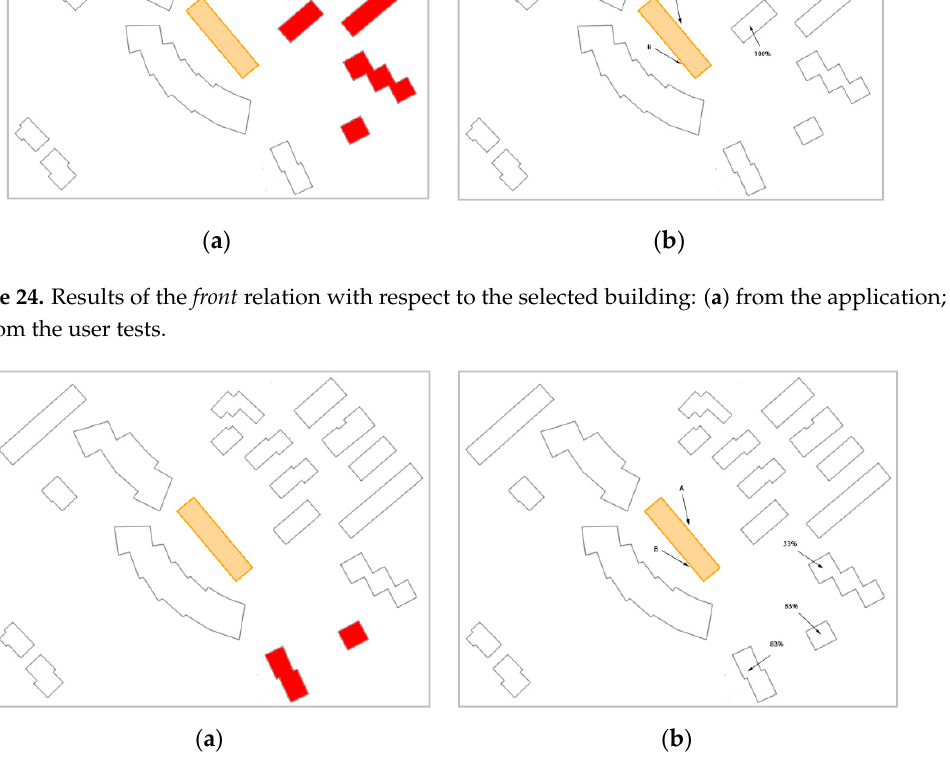
Figure 25 . Results of the rightside relation with respect to the selected building: ( a ) from the application; ( b ) from the user tests.